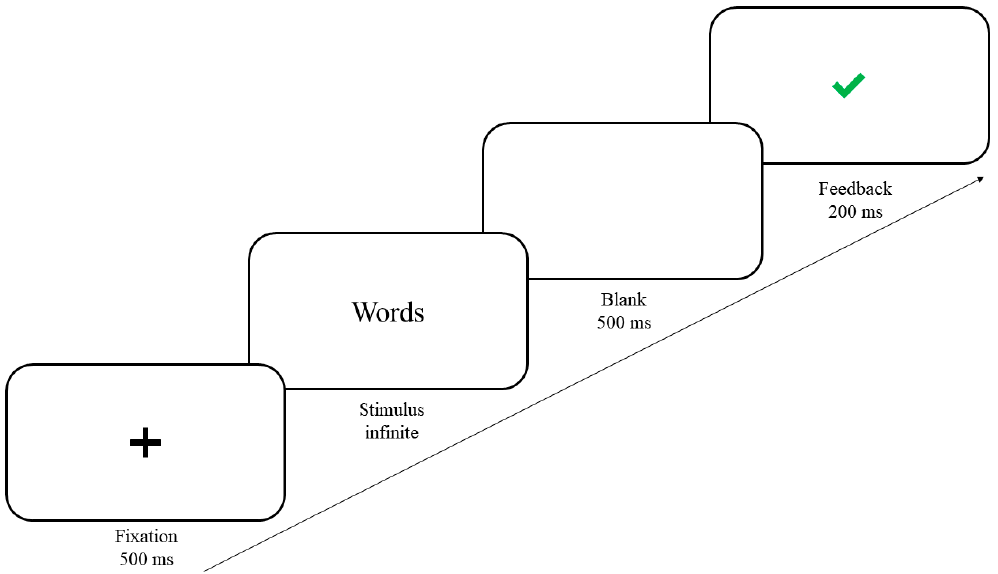
Figure 2. Flow chart of a SC-IAT trial.